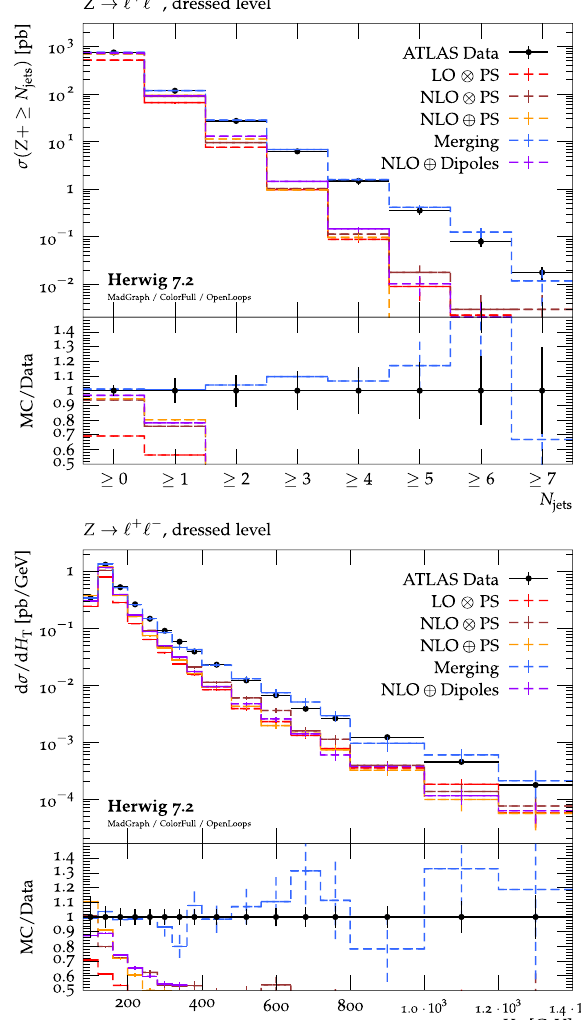
Fig. 12 The cross section for Z production in association with N jets jets (upper) or differentially with respect to the total scalar sum of final state transverse momenta, H T , (lower) in comparison with ATLAS data [65]